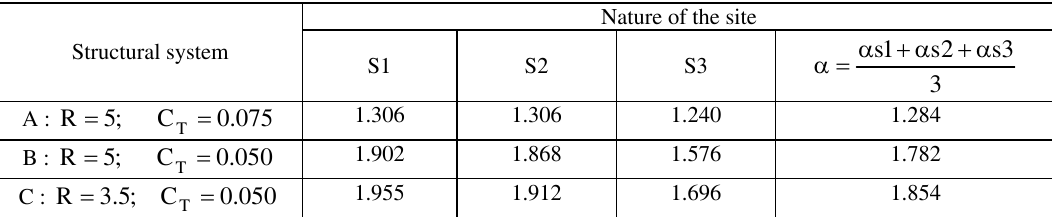
Table 2. Mean values of the amplification period coefficient α , considering site effect